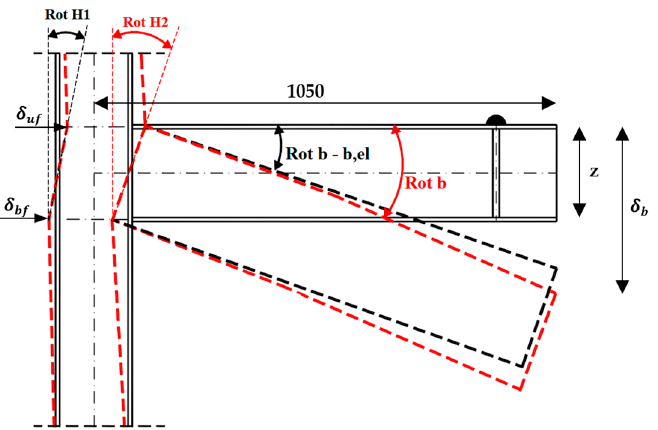
Figure 11. Rotation components of the joint for the determination of connection rotation [27].